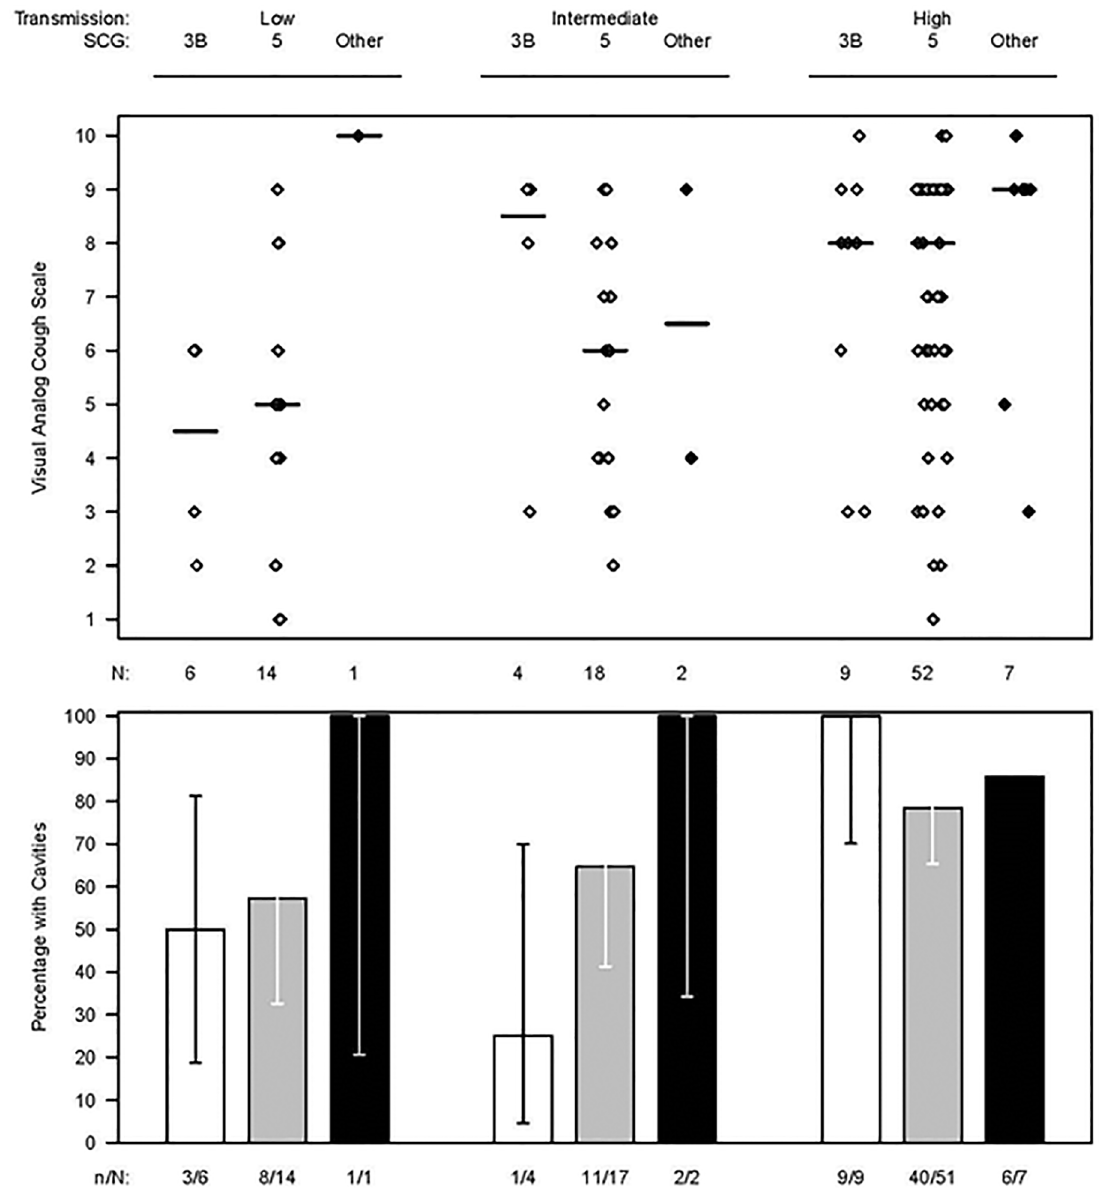
Figure 2. Cough severity (as measured by visual analog cough scale) in index TB case by household transmission category, single nucleotide polymorphism genetic cluster group (SCG), and cavitations on chest radiograph